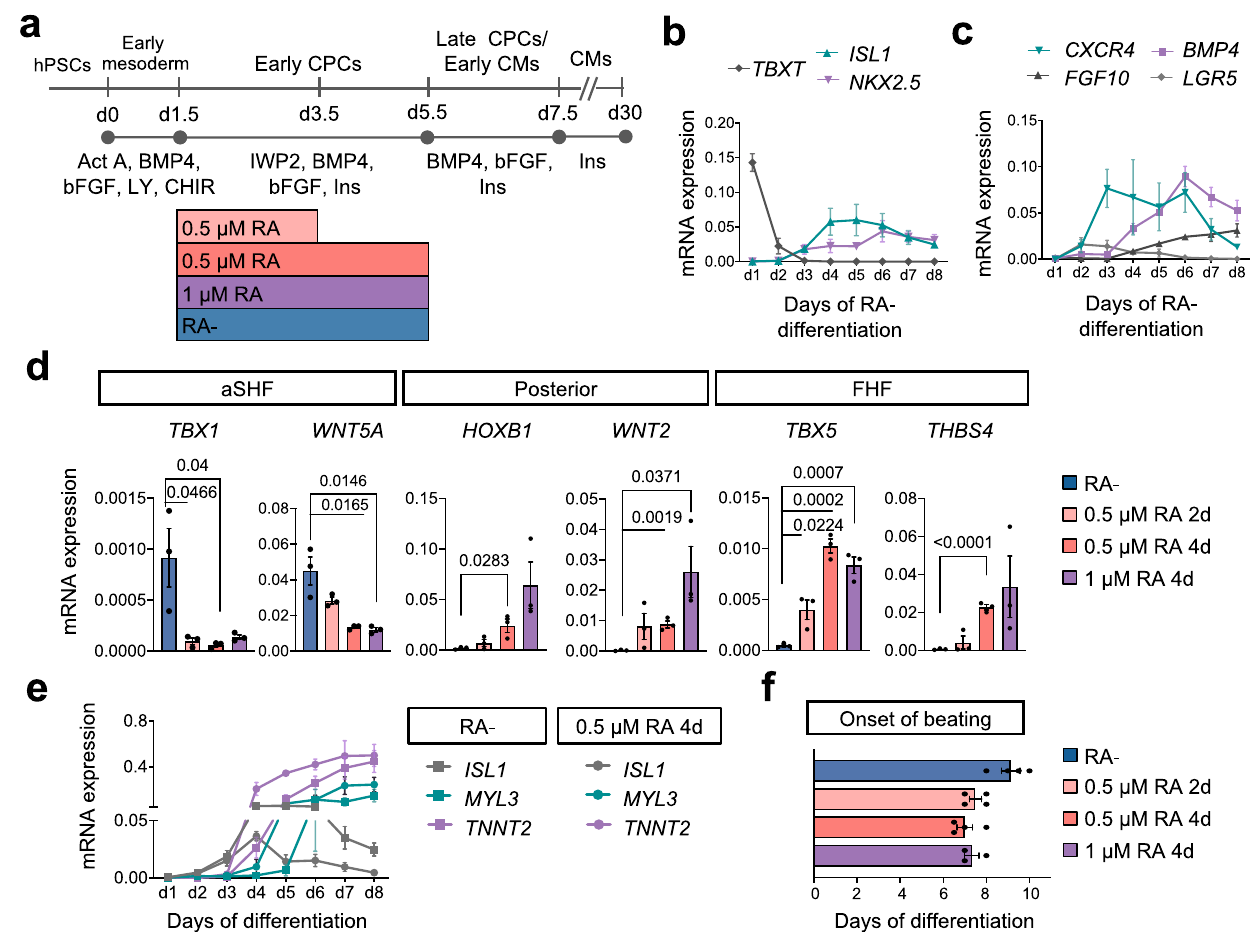
Fig. 1 | RA signaling modulation impacts cardiovascular progenitor speci fi ca- tion. a Schematic representation of the protocol used to differentiate human pluripotentstemcells(hPSCs)intocardiomyocytes(CMs)throughde fi nedstepsof early mesoderm and cardiovascular progenitor cells (CPCs) without retinoic acid (RA − ) or with RA added at the indicated dosages and times. Act A Activin A, CHIR CHIR-99021, LY LY-29004, Ins insulin. b , c Time course of mRNA expression of b TBXT, ISL1, NKX2.5 , and c CXCR4 , FGF10 , BMP4 , LGR5 during differentiation withoutRA.Dataaremean±SEM.For FGF10n =4independentexperiments;forall other genes n =3. mRNA expression relative to GAPDH . d mRNA expression of key